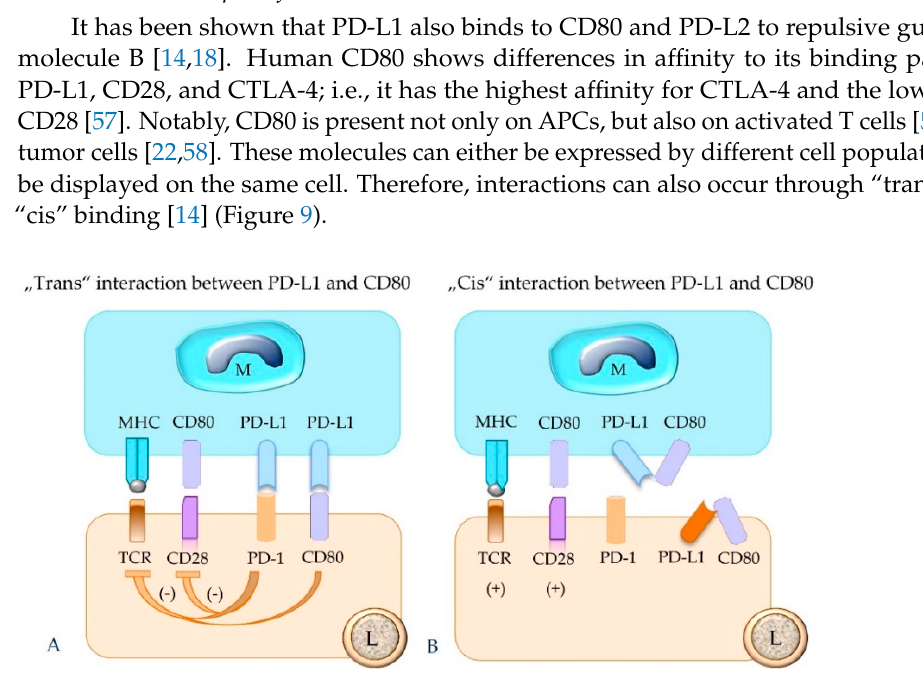
Figure 9. PD-L1 expressed by a macrophage (M, as depicted), tumor cell, or regulatory T cell can also bind to CD80 of a lymphocyte (L). This results in inhibition of the functional activity of the PD-1-bearing target cell ( A ). The “cis” interaction of PD-L1 and CD80 molecules on the same cell, e.g., a macrophage or lymphocyte, prevents their binding in “trans” and thus counteracts their inhibitory function ( B ). TCR = T cell receptor; MHC = major histocompatibility complex class I or II molecule; PD-1 = programmed cell death protein 1; PD-L1 = programmed death-ligand 1.